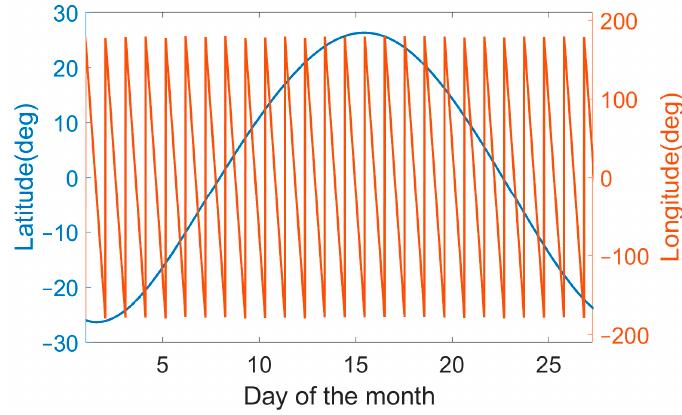
Figure 8. Latitude and longitude of sublunar points over one orbital period.